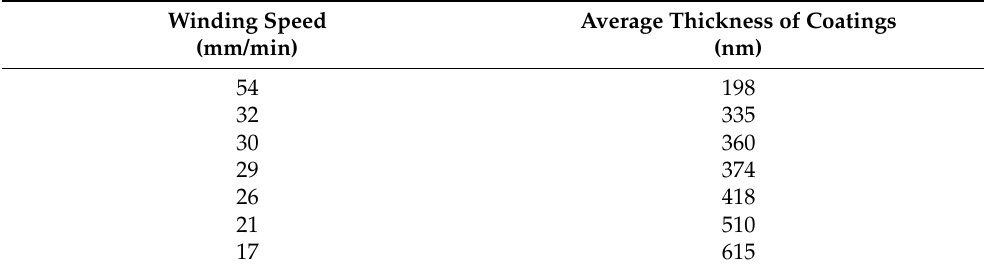
Table 1. Average thickness of the siloxane coatings prepared with different winding